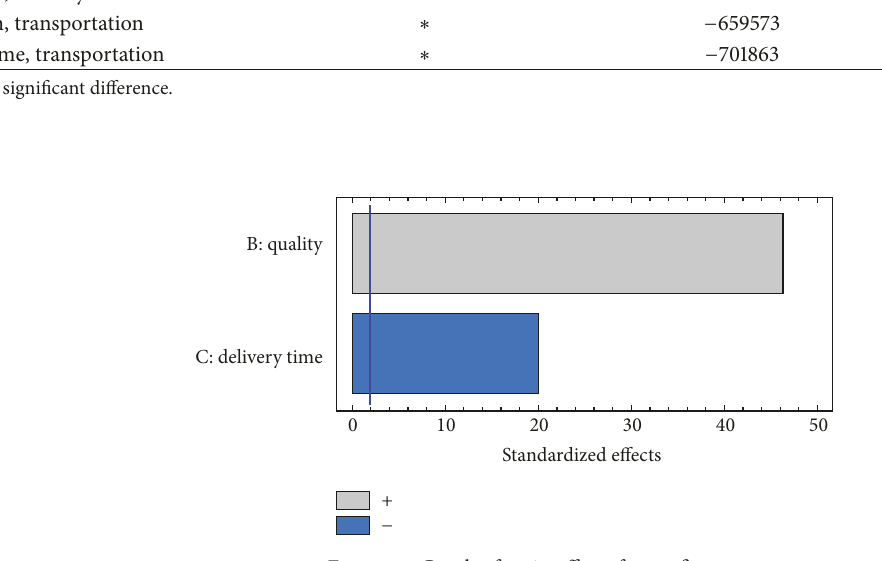
Figure 5: Graph of main effects for